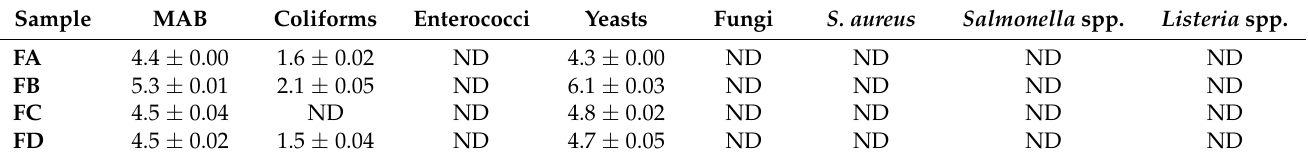
Table 2. Occurrence of monitored microbiological indicators (log CFU/mL) in fruit